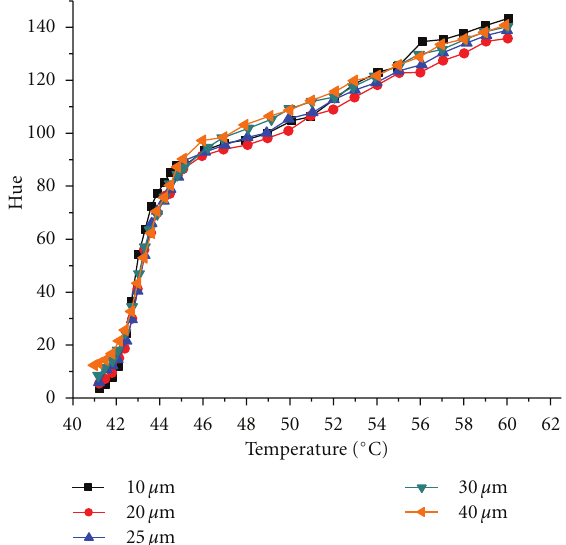
Figure 6: E ff ect of the TLC coating thickness on the hue curves.